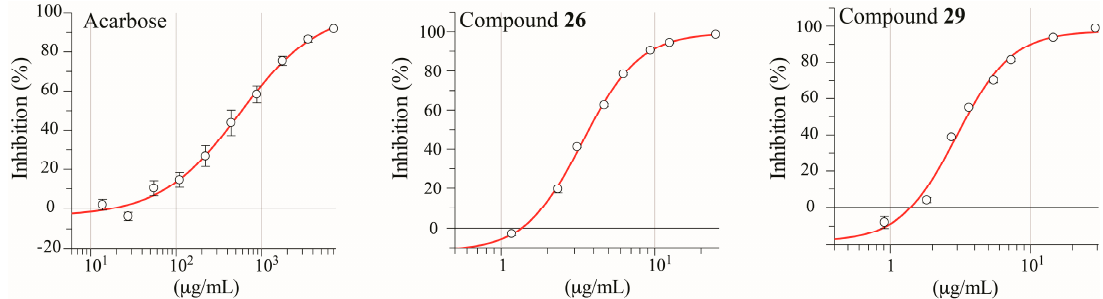
Figure 4. IC 50 curves of Acarbose, 26 and 29 . Table 1. Inhibitory activities of the bioactive compounds and reference compound acarbose.